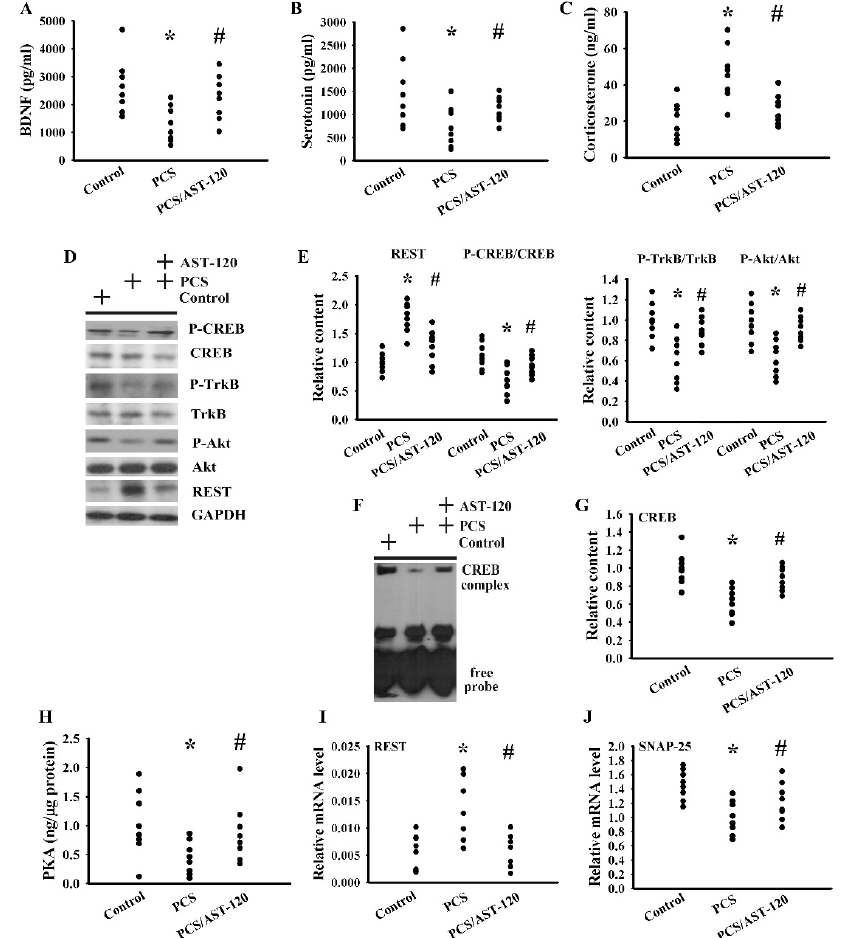
Figure 6. PCS decreased the parameters of the neurotrophins. Unilateral nephrectomized mice were intraperitoneally injected with PCS (0, Control; and 100 mg/kg, PCS) and the PCS-injected mice were orally given with AST-120 (400 mg/kg, PCS/AST-120) for 7 weeks. The serum samples were collected and subjected to the measurement of the BDNF ( A ), serotonin ( B ), and corticosterone ( C ) levels. Proteins were extracted from the isolated prefrontal cortical tissues and subjected to a Western blot test with the indicated antibodies. Representative blots ( D ) and the quantitative data ( E ) are shown. Nuclear proteins were extracted from the isolated prefrontal cortical tissues and subjected to EMSA for the measurement of CREB DNA-binding activity. Representative blots ( F ) and the quantitative data ( G ) are shown. ( H ) The prefrontal cortical tissues were isolated and subjected to the measurement of PKA activity. Total RNAs were extracted from the isolated prefrontal cortical tissues and subjected to quantitative RT-PCR for the measurement of the REST ( I ) and SNAP-25 ( J ) mRNA level. * p < 0.05 vs. control group and # p < 0.05 vs. PCS group, n = 8.